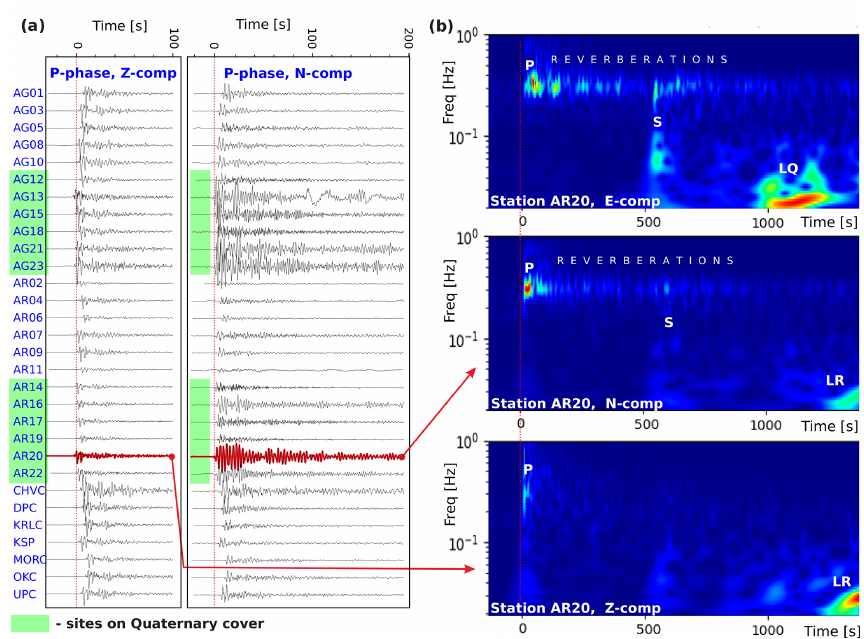
Figure 14. Seismic data example for event from 30 November 2018, 17:29:26UTC, illustrating the differences in P-phase records between stations located on consolidated basement (short pulse, no reverberations) and sites located on young, unconsolidated cover (green rectangles, strong reverberations on the horizontal components). (a) Z and N component records for all the stations used. (b) Three-component spectral seismograms for station AG20. E and N components show high amplitude, > 600s long coda (reverberations) in a narrow frequency range, centred at 0.3Hz. The coda is non-existent in the Z -component record. True amplitude scaling was applied. The timescale is relative to theoretical P-phase onset.